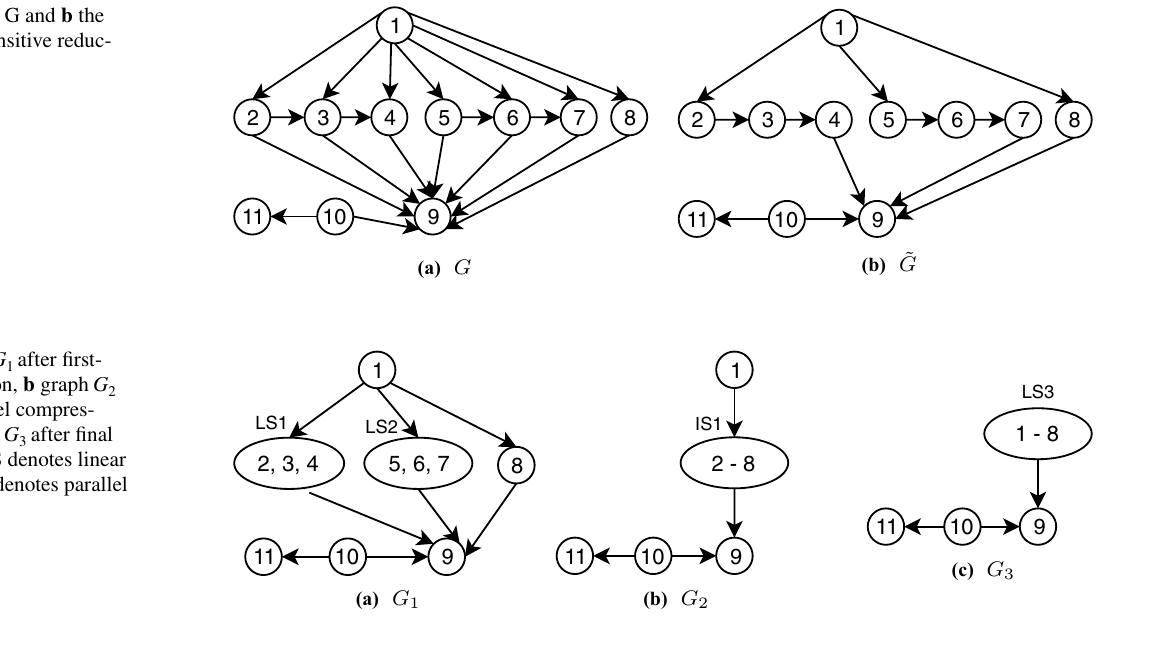
Fig. 3 a A DAG G and b the ̃ G DAG after transitive reduc- tion